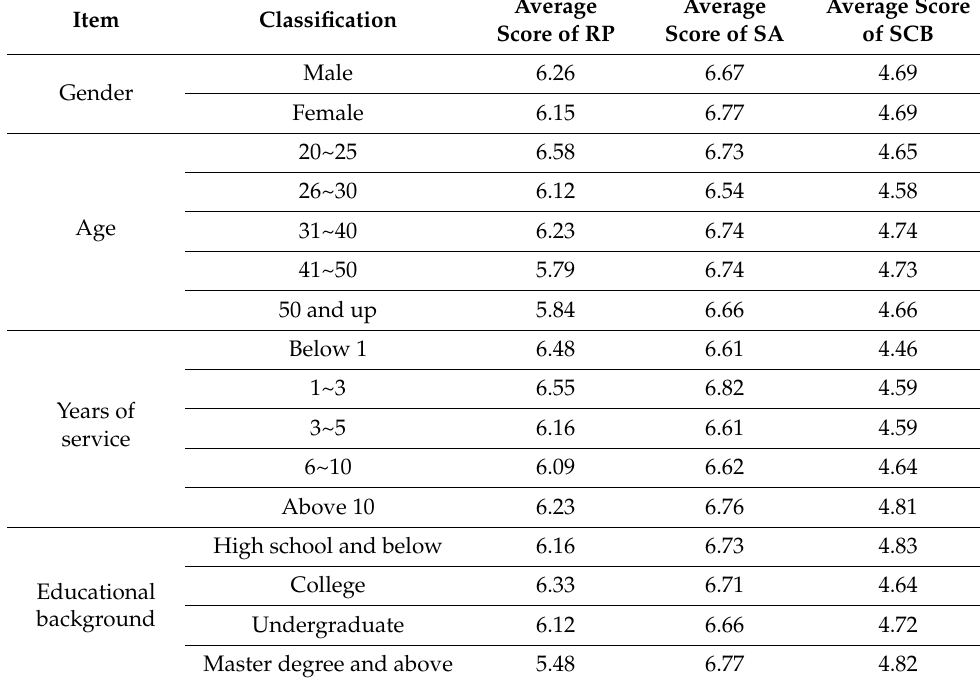
Table 12. Average score of RP, SA and